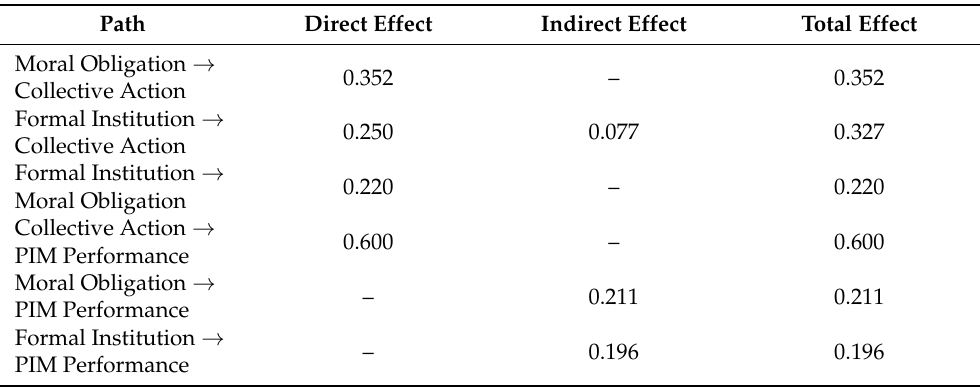
Table 4. Direct effect, indirect effect, and total effect among latent